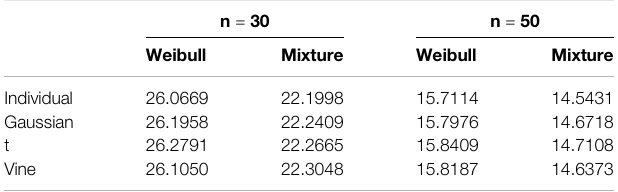
TABLE 9 | The average Mean Squared Error of aggregate losses for states in Group 3.